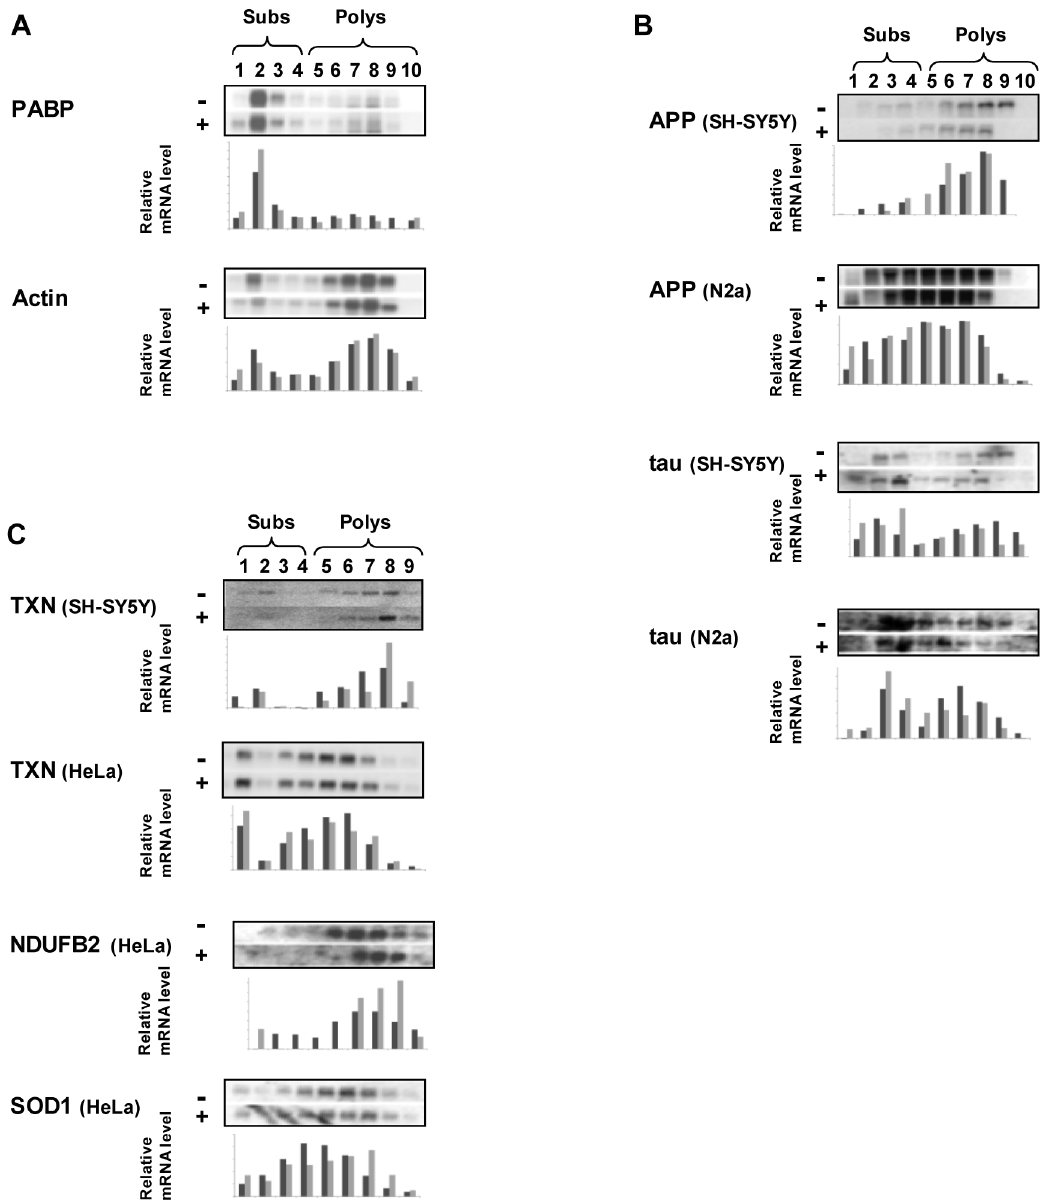
Figure 1. eIF4A inhibition changes the polysomal association of certain mRNAs. Cultured cells (SH-SY5Y, N2a or HeLa) were treated with 10 m M hippuristanol ( + ) or DMSO control ( 2 ) for 10 minutes, lysed and mRNA fractionated on a 10%–50% sucrose gradient. OD260nm absorbance was determined with simultaneous 1 ml fraction collection to determine subpolysomal and polysomal fractions (fraction number and subpolysomal or polysomal association indicated). Northern analysis was performed to determine the positions of mRNAs for: A Actin and PABP which do not change in polysome associations; B APP and tau which become less polysomally associated; C TXN, NDUFB2 and SOD1 which become more polysomally associated. Relative levels of RNA are indicated by dark grey (DMSO control) and light grey (10 m M hippuristanol) bars beneath each fraction, as percentages of the total amount RNA in each gradient.